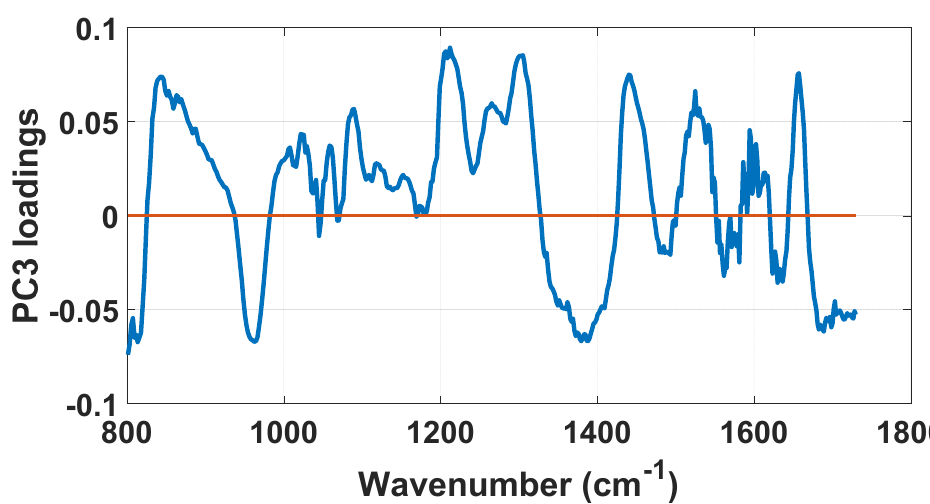
Figure 9. Wavenumber-dependent PC3 loadings and the zero line (red) for easier visualization of the absolute amplitude of loading values.